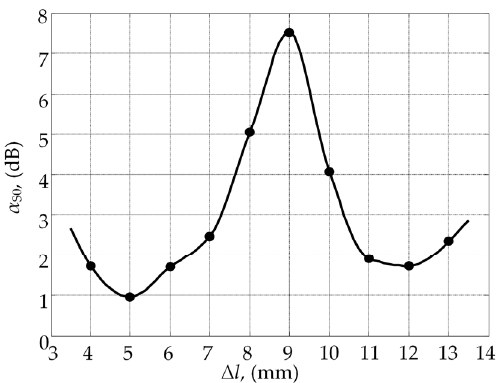
Figure 4. The transmission losses α S0 ( f ) of the S 0 guided wave mode in the case of different lap joint overlap zone width Δ l .